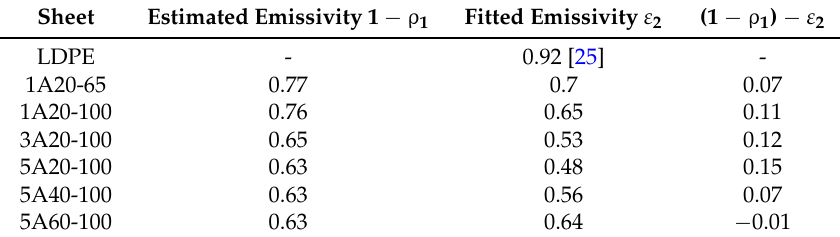
Table 4. Estimated emissivity and fitted emissivity of coated sheets